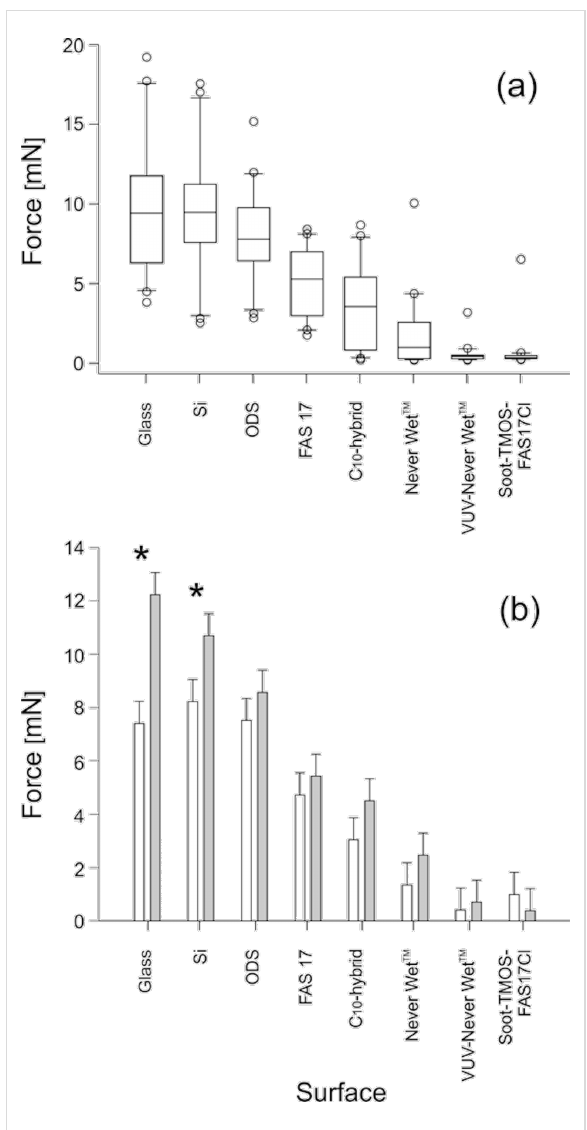
Figure 3: Traction forces of Coccinella septempunctata beetles measured on different sample surfaces: (a) data on males and females pooled together; (b) males (grey bars) and females (white bars). Aster- isks in (b) indicate statistically significant differences between forces generated by males vs females (Tukey test, P <